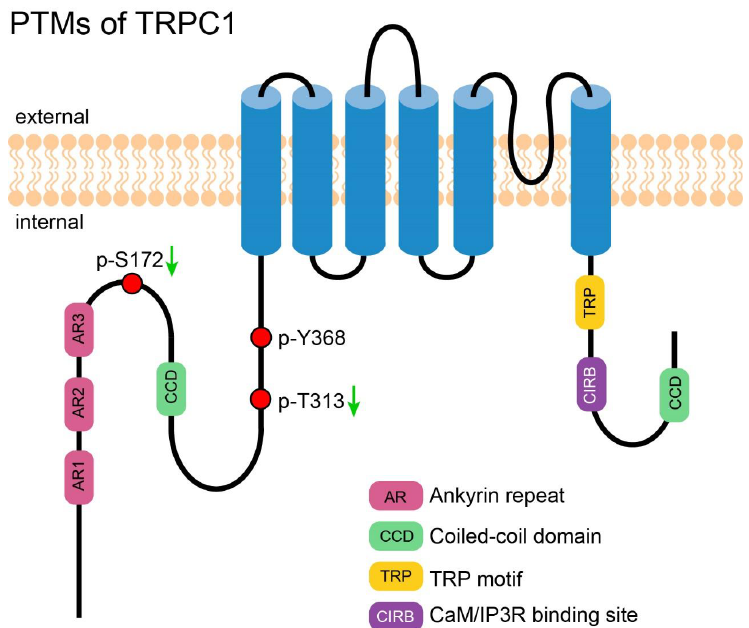
Figure 1. PTMs of TRPC1. A cartoon depicting TRPC1 with its important motifs and Post-translational modifications (PTMs — those exact positions had been reported). PTMs are presented in circles. Red circles represent the reported phosphorylation sites of TRPC1, which are labeled in the format of a “p-amino acid-position”. The green arrows near the labels denote the PTMs decreasing the channel’s